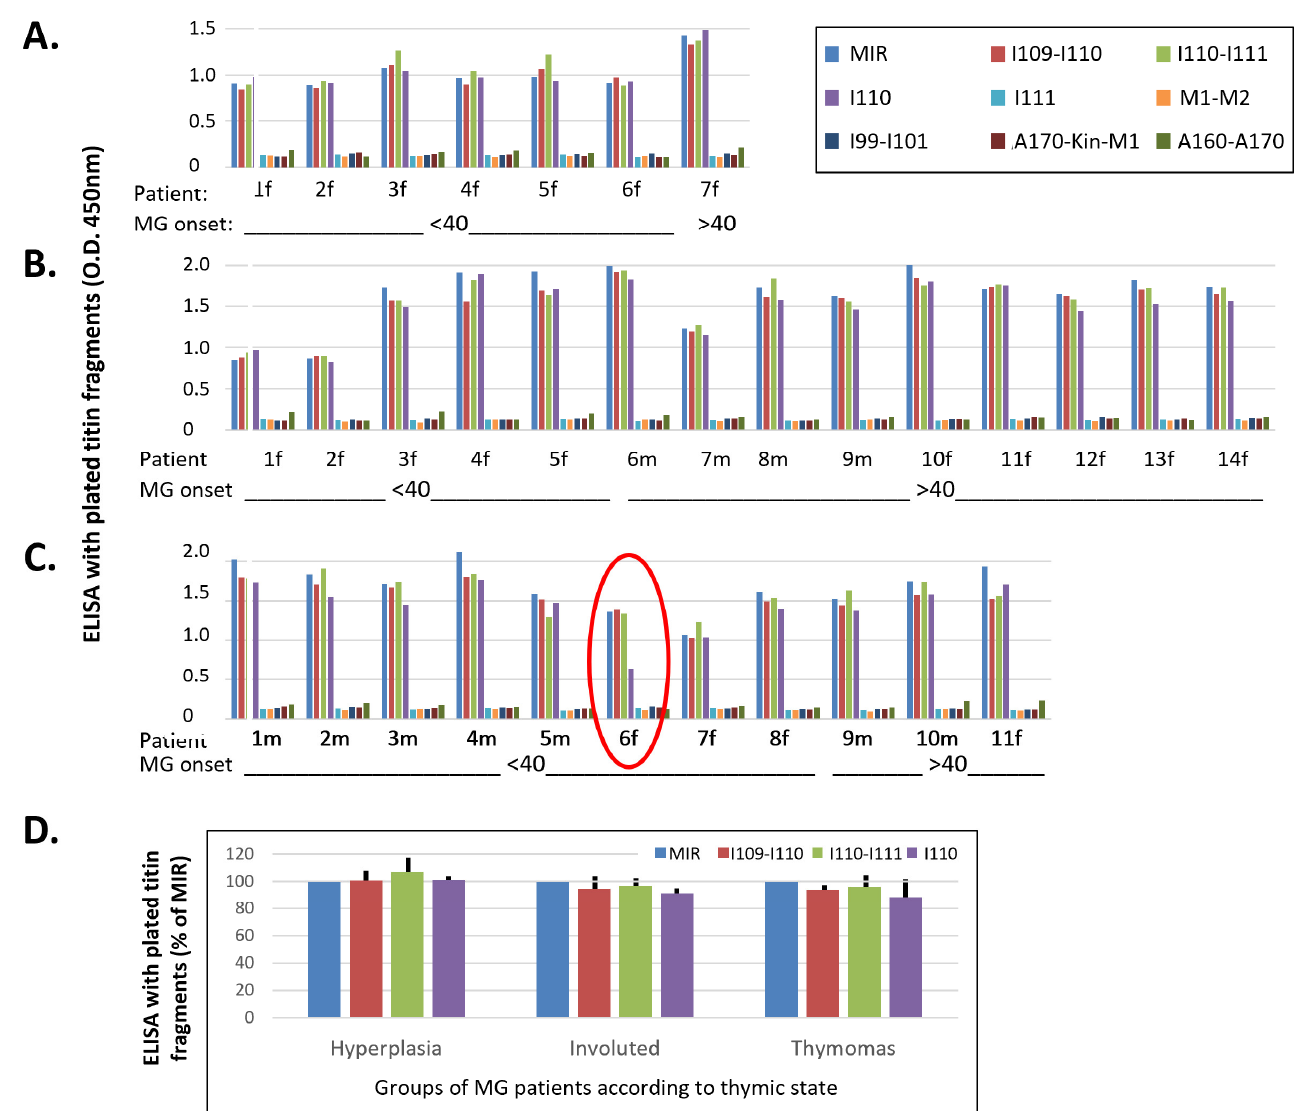
Figure 4. Search for correlation of thymoma state, age at onset and gender of MG patients versus the binding pattern to titin fragments. ( A – C ): Sera from 3 groups of MG patients with hyperplastic thymus ( A ), involuted thymus ( B ), or thymoma ( C ), further placed in subgroups of early onset (<40 years) and late onset MG, males or females, were tested for binding to the 9 fragments: MIR, I109-I110, I110-I111, I110, I111, M1-M2, I99-I101, titin kinase region A170-Kin-M1 and polyFn. In each group, first are shown the sera from early onset (<40) MG and then from late onset, and in each subgroup the male patients are placed first, followed by the females (marked with m, f next to patient number). The encircled patient C6 is the only one in the whole study whose serum was bound to I110 only about 47% of its binding to each of the other 3 samples. ( D ) Average percentages of antibody binding of the 3 groups of sera to I109-I110, I110-I111 and I110, versus the values of antibody binding to the MIR. The differences are not statistically